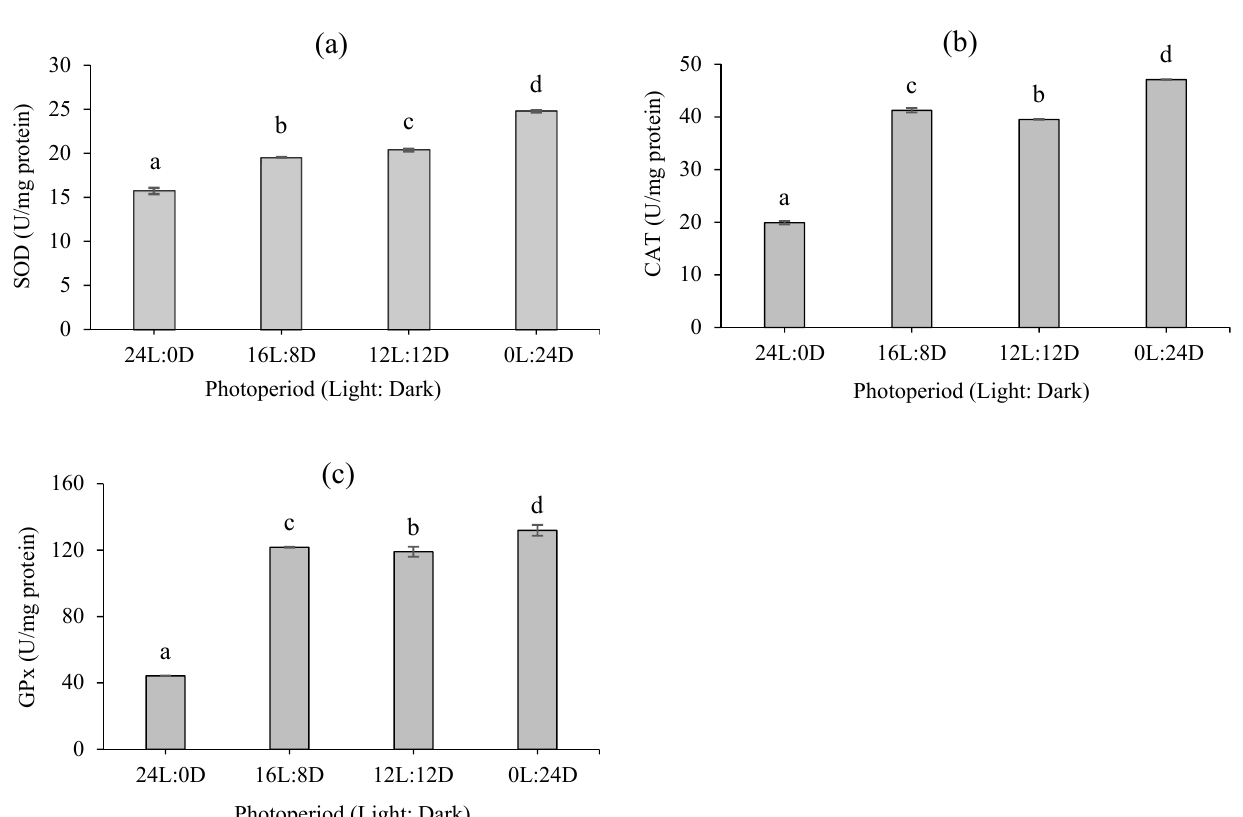
Figure 4. Antioxidative enzyme activity of B. orientalis at the end of the trial (mean ± SD, n = 3): ( a ) superoxide dismutase (SOD), ( b ) catalase (CAT), and ( c ) glutathione peroxidase (GPx). Different superscript letters denote statistically significant differences at p < 0.05. Table 3. Proximate body composition (% dry matter) of B. orientalis cultured under different photoperiods (mean ± SD, n = 3). Proximate Composition